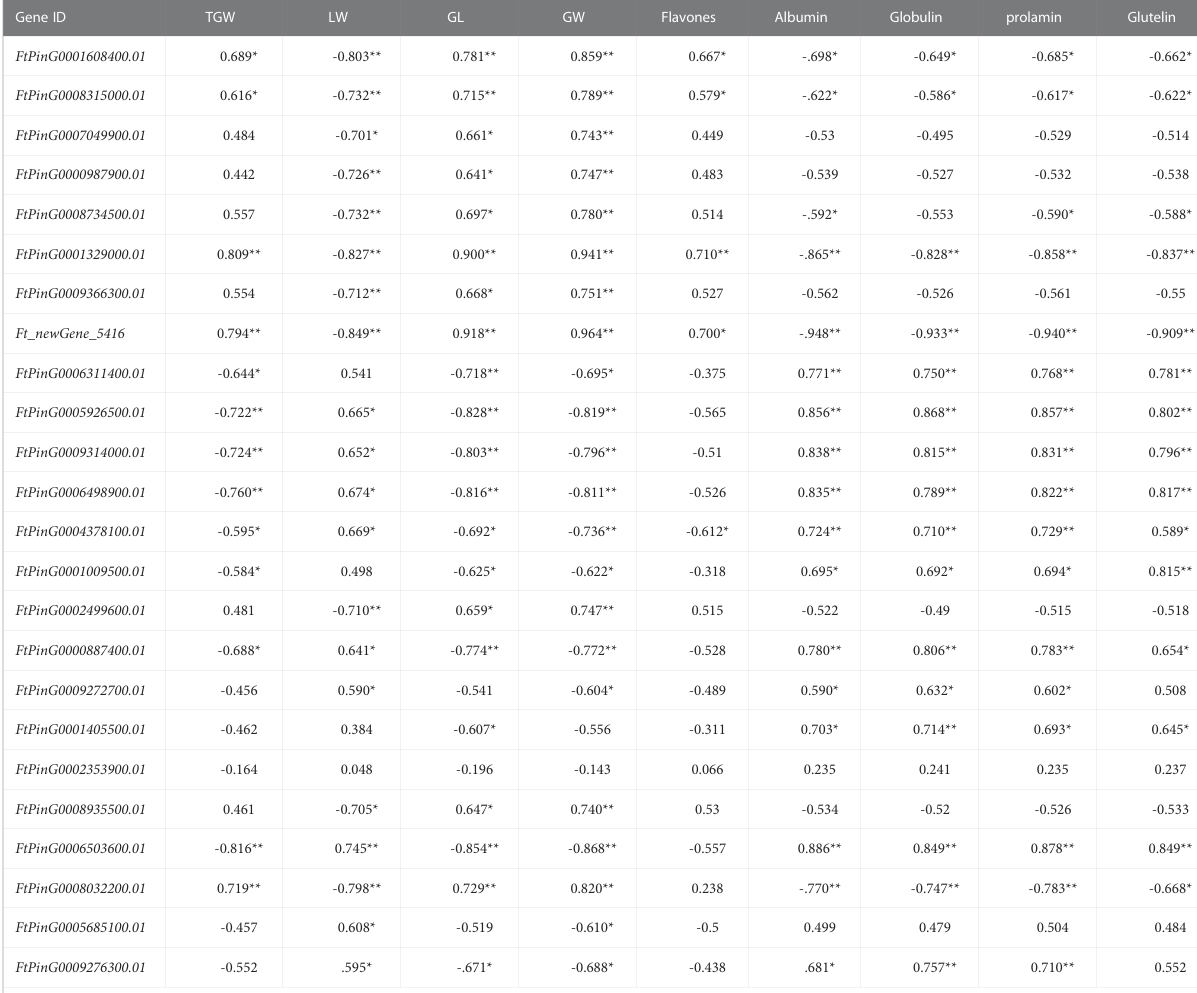
TABLE 4 Correlation analysis of candidate gene expression with yield and quality traits. Gene ID